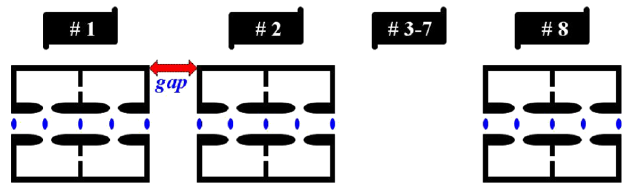
FIG. 15. Schematic of normal conducting cavity arrangement.